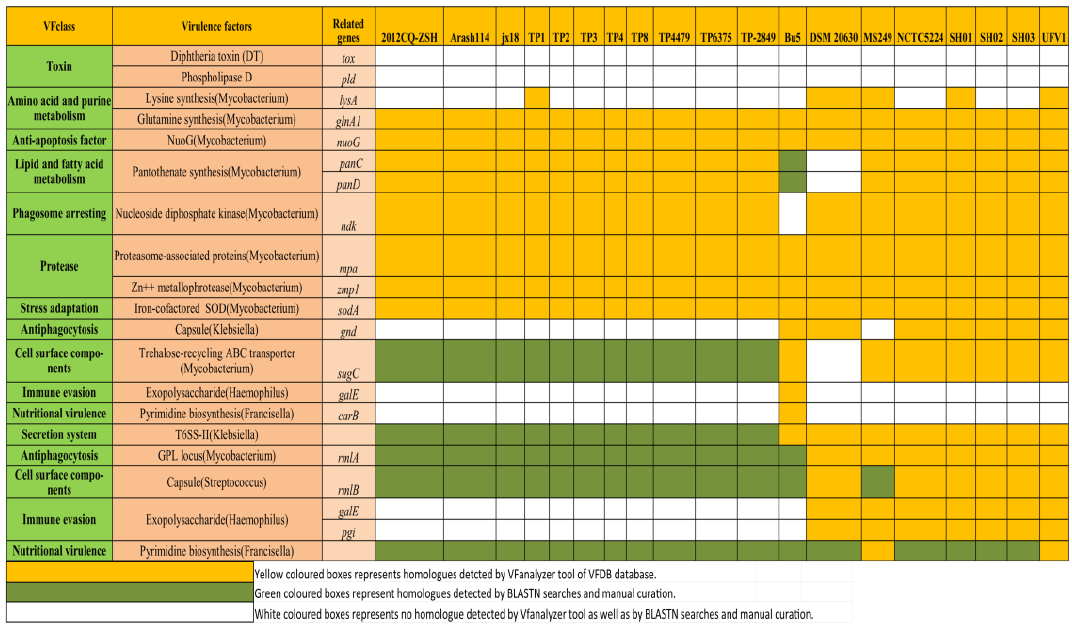
Figure 8. Distribution of CVFs in the nineteen investigated T. pyogenes strains belonging to functional classes of toxin, amino acid and purine metabolism, anti-apoptosis factor, lipid and fatty acid metabolism, phagosome arresting, protease, and stress adaptation, anti-phagocytosis, cell surface components, immune evasion, nutritional virulence, and secretion